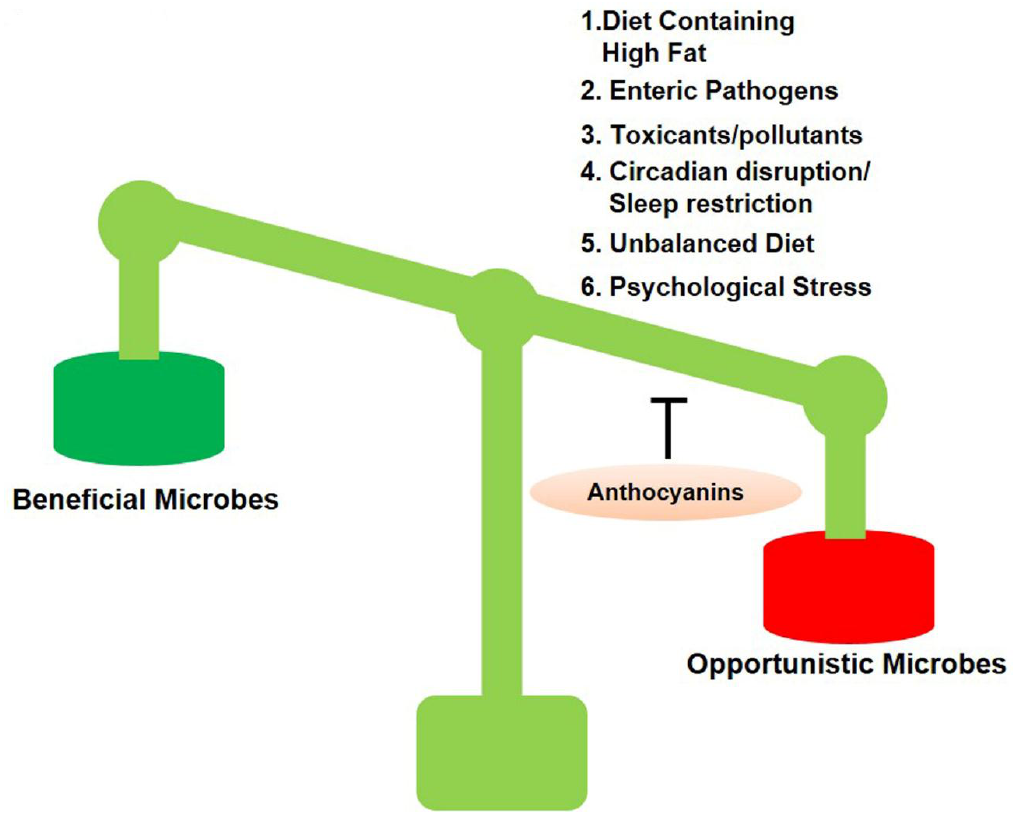
Figure 1. Anthocyanins switch population of opportunistic bacteria. Several factors provide opportunities to harmful